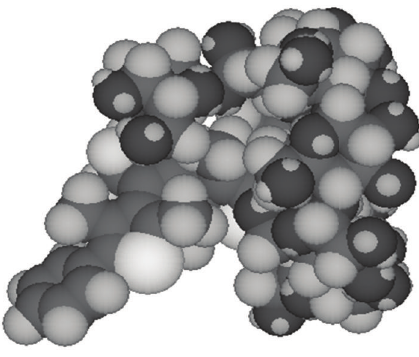
Figure 6: Minimum-energy structure of the DE/m- 𝛽 -CD complex calculated by